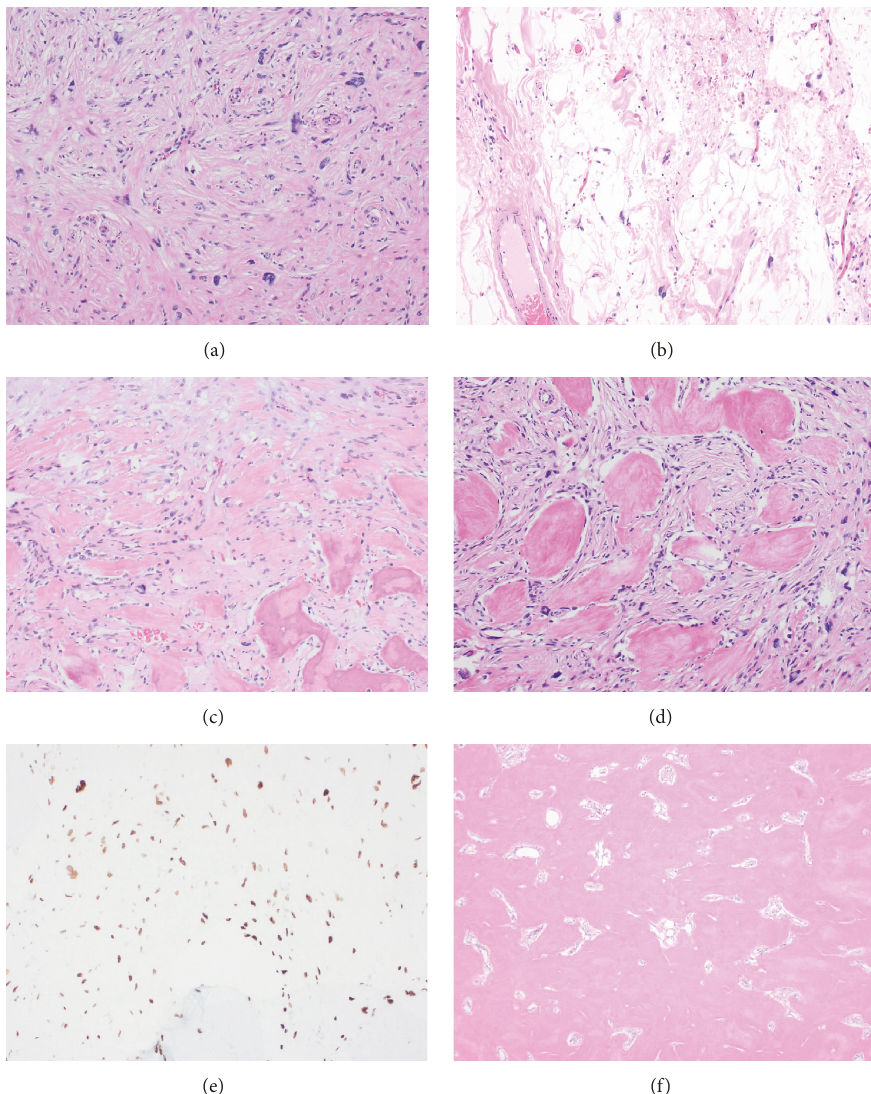
Figure 3: (a) Cellular high-grade nonlipogenic sarcoma component composed of spindle and pleomorphic tumor cells (100X). (b) Focal transition into a well-differentiated liposarcoma with atypical stromal cells (100X). (c, d) Nonlipogenic sarcoma with osteoid matrix and highly atypical cells, resembling a high-grade osteosarcoma (100X). (e) Immunohistochemical staining for SATB2 is positive in osteoblastic cells and intervening atypical cells. (f) Areas of thick interconnected trabeculae of immature woven bone lacking osteoblastic rimming